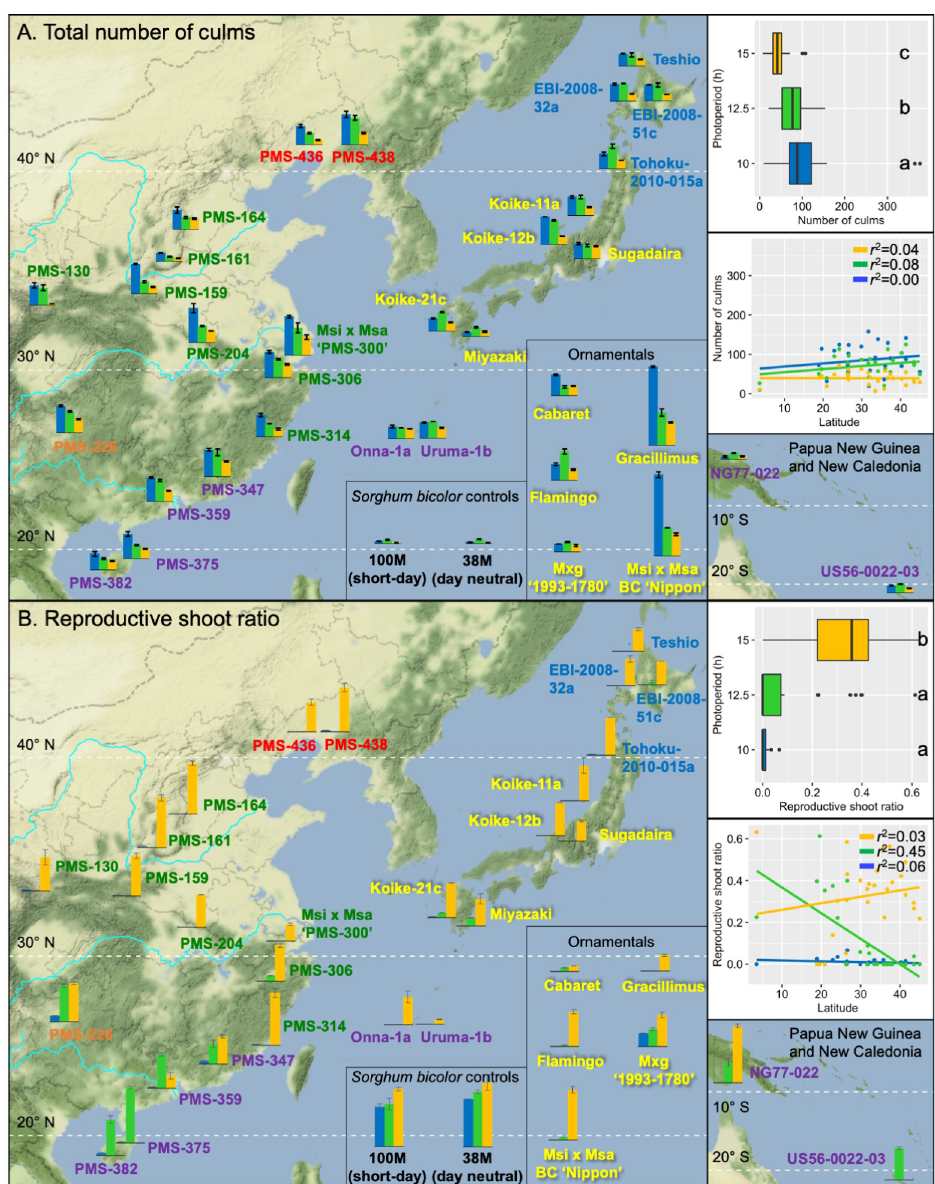
Fig 4. Effects of day length on total number of culms (A), and reproductive shoot ratio (B) for 33 Miscanthus and two Sorghum bicolor genotypes grown in controlled environment chambers at constant 23 ˚C. The Miscanthus genotypes included 28 M . sinensis , 2 M . floridulus , 2 diploid M . × giganteus , and 1 triploid M . × giganteus . The genotypes were evaluated for response to three day-length treatments: 15 h (orange data), 12.5 h (green data) and 10 h (blue data), respectively. Collection sites of the wild-collected genotypes are shown by their placement on the geographic map. Miscanthus genotype names are printed in colors representing six M . sinensis genetic groups identified by Clark et al . [23, 24], which included Korea/North China (red), Yangtze-Qinling (green), Northern Japan (blue), Southern Japan (yellow), Sichuan Basin (orange), and Southeastern China plus tropical (purple); for interspecific hybrids between M . sacchariflorus and M . sinensis , the dominant M . sinensis genetic group is shown. The inset boxplots depict variation among and within the three day-length treatments; treatments labeled with the same letter were not significantly different based on Tukey’s HSD test at α = 0.05. The inset regression plots show linear relationships between traits and absolute values of latitude at collection sites for the 28 Miscanthus genotypes with geographical